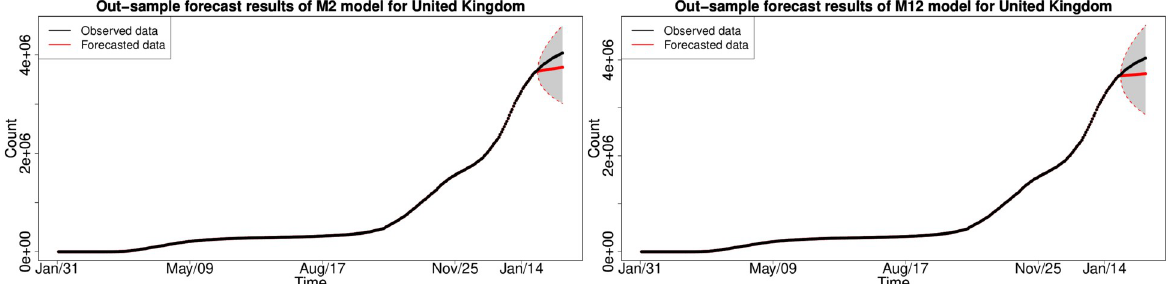
Fig 15. Out-of-sample forecast results for the United Kingdom. Out-of-sample forecast plot for the UK by Model 2 (left) and Model 12 (right).